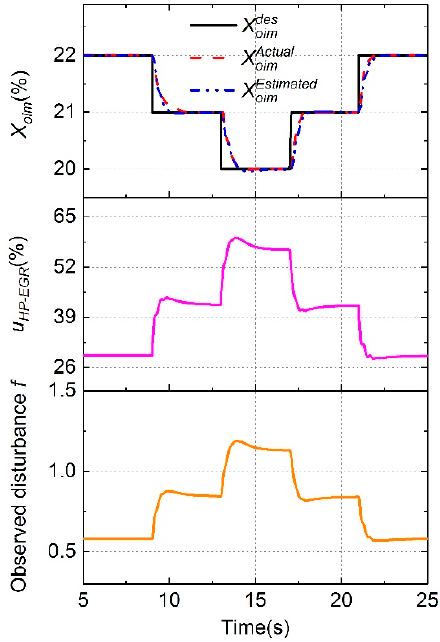
Figure 13. OADRC validation with step changes of desired intake oxygen concentration.